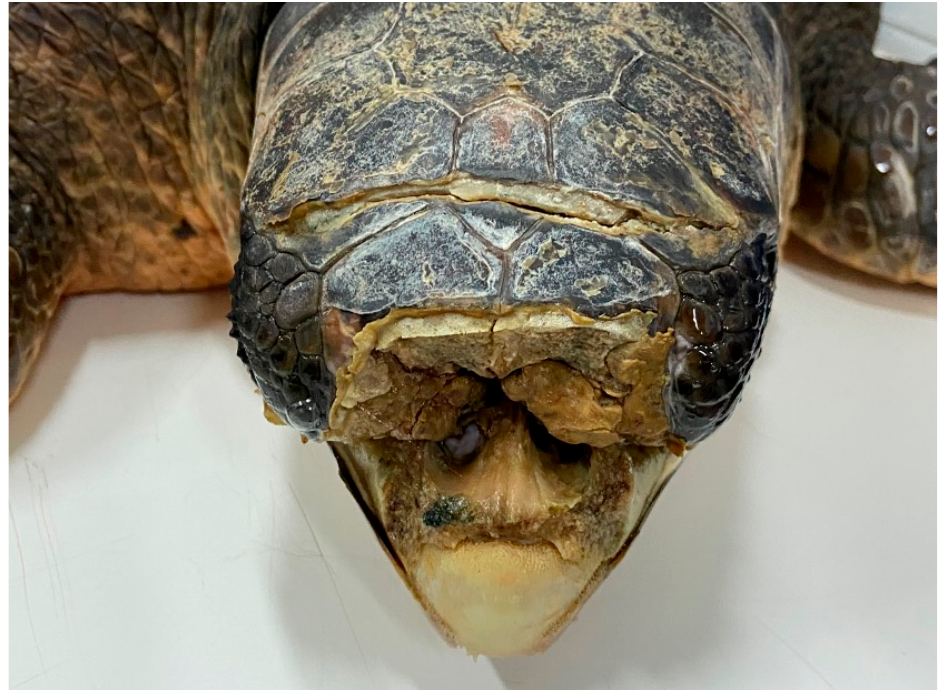
Figure 5. Examples of concomitant pathologies in sea turtles hospitalized for head trauma at the STC. ( a ) Severe entanglement of the left anterior fin resulting in amputation. ( b ) X-Ray in latero-